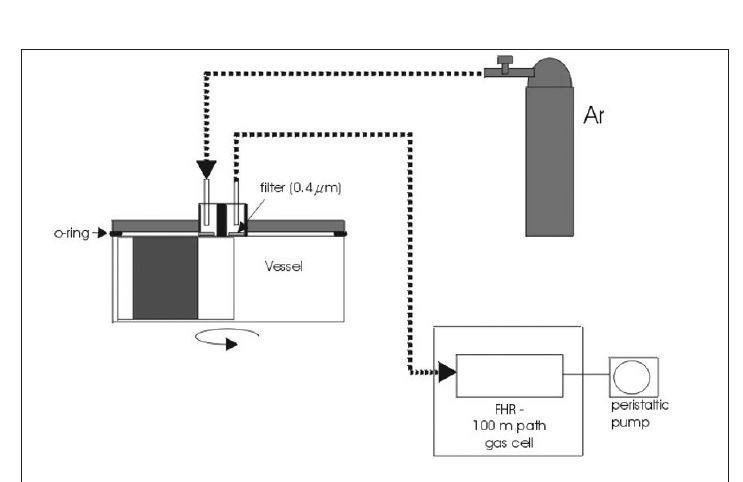
Fig. 1. Layout of experimental apparatus.